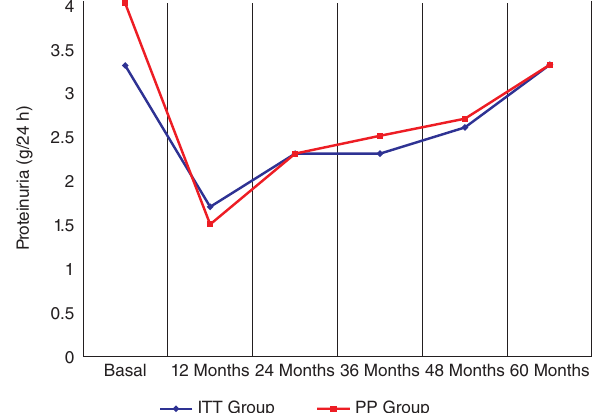
Figure 2. ITT and PP analysis for proteinuria levels. IIT, Intention to treat analysis; PP, per-protocol.